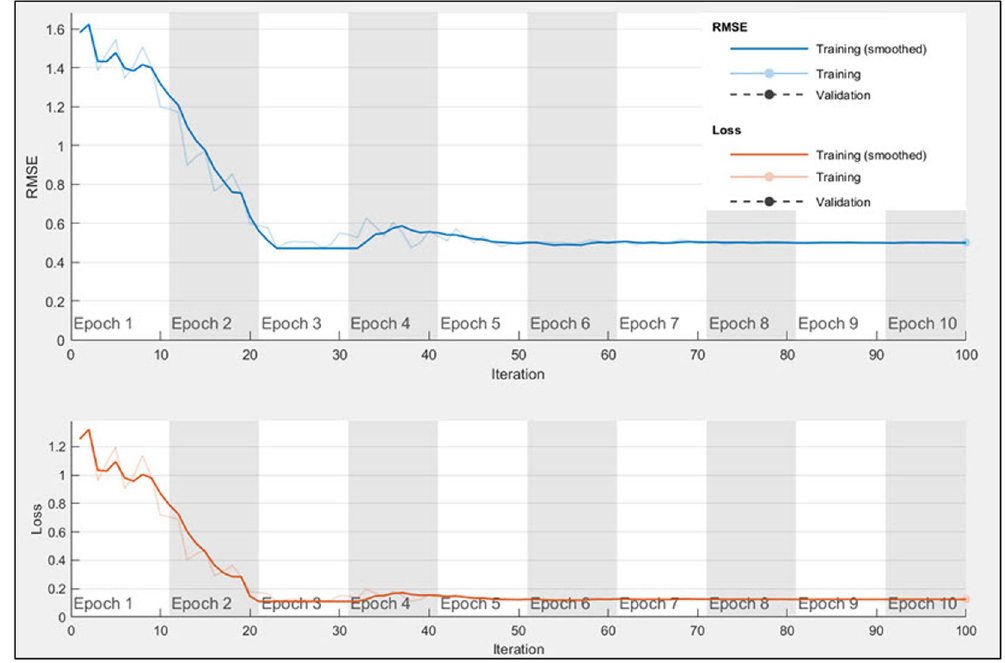
Figure 6. Graph showing how the LSTM network learns the hyper-parameters to minimize the loss function.